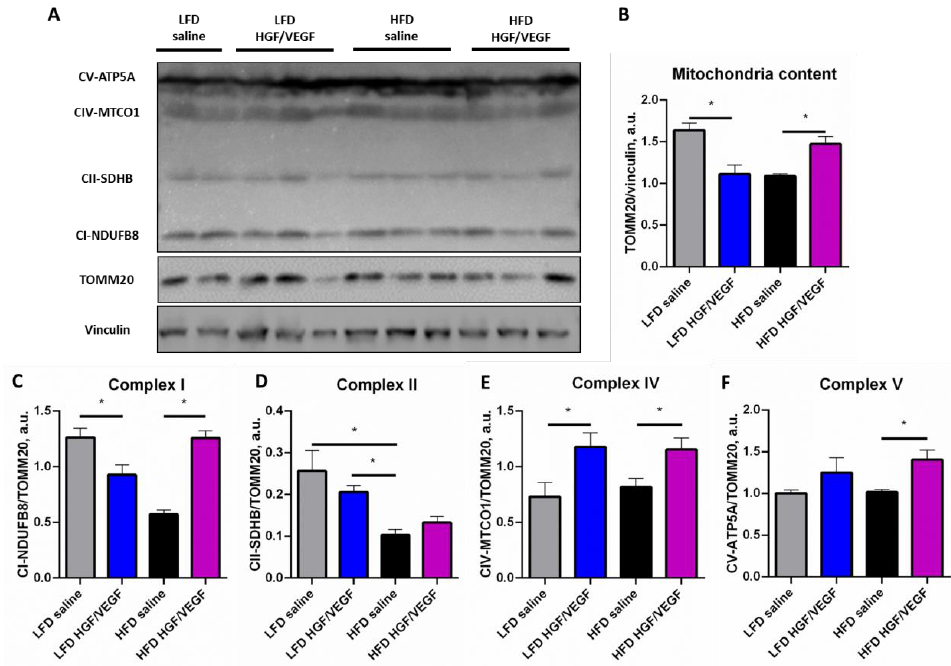
Figure 6. HGF/VEGF combined plasmid suppresses mitochondrial biogenesis and electron transport chain (ETC) input components expression in LFD conditions, but enhances these parameters in HFD conditions. (10 + 3 weeks of experiment). ( A ) representative Western blots panel; ( B ) mitochondria content in ischemic muscle; ( C ) NADPH-dehydrogenase (Complex I) expression level in ischemic muscle, ( D ) succinate dehydrogenase (Complex II) expression level in ischemic muscle; ( E ) cytochrome C oxidase (Complex IV) expression level in ischemic muscle; ( F ) ATP-synthase (Complex V) expression level in ischemic muscle. Data is presented as mean ± SEM, the Kruskal–Wallis test with post hoc Dunn’s test; * p <